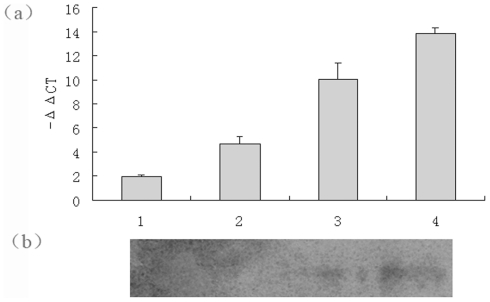
Transcription and expression level of BmTHY in different development stages of Bombyx mori.(a) Analysis of BmTHY expression was performed by RT-PCR. Relative BmTHY expression was determined in relation to the corresponding BmTHY expression level in the silkworm moth: ΔΔCT (stage) = ΔCT (stage)−ΔCT (egg); (b) Western blotting analysis of the expression levels of of BmTHY in different development stages. 1,egg;2,pupa; 3,larva;4,moth.